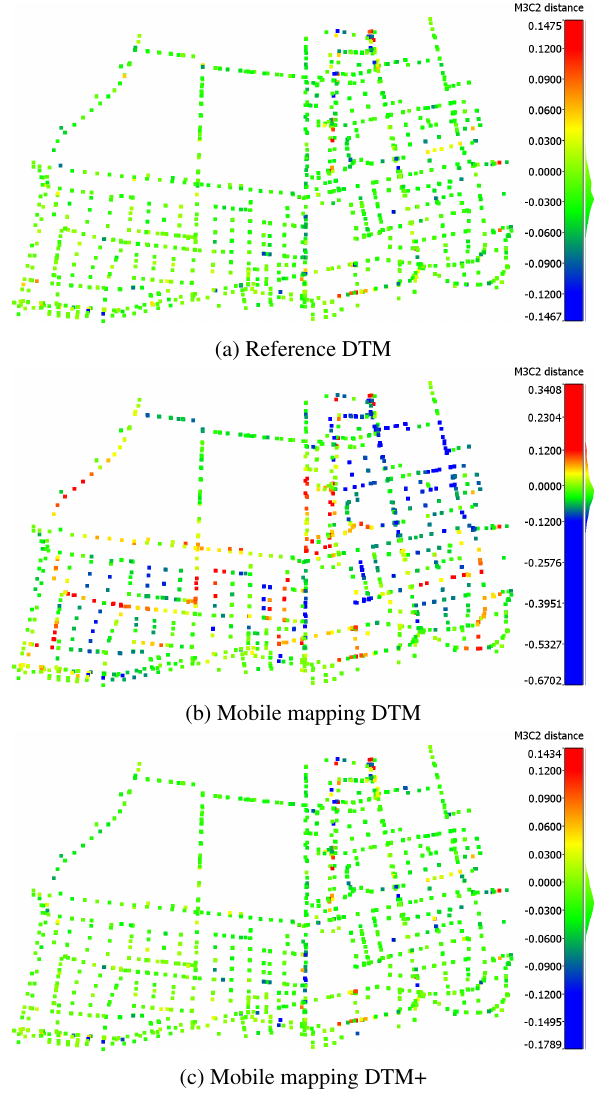
Figure 13. Height Difference between Leveling Measurements of manholes and the DTMs (red for 0.12 m and blue for -0.12 m) From the results above, we can identify that the reference DTM generated from ALS has a higher absolute height accuracy than the DTM generated by mobile mapping measurements. There- fore, before the merging step, the height differences between the